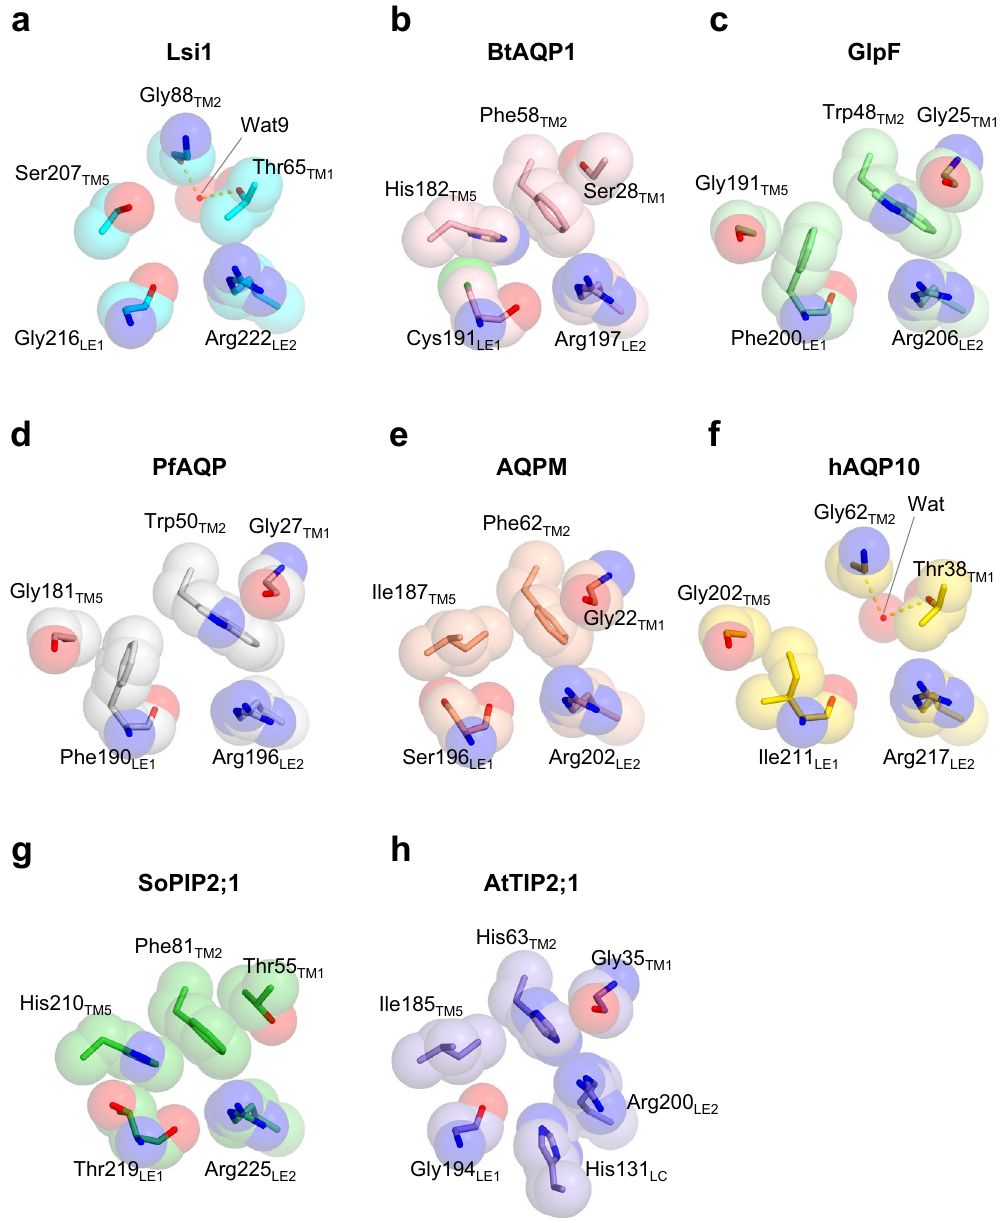
Fig. 3 Comparison of SFs of Lsi1 and other AQPs. SF of Lsi1 cryst ( a , cyan, PDB 7CJS), BtAQP1 ( b , pink, PDB 1J4N), GlpF ( c , light green, PDB 1FX8), PfAQP ( d , white, PDB 3C02), AQPM ( e , khaki, PDB 2F2B), hAQP10 ( f , yellow, PDB 6F7H), SoPIP2;1 ( g , green, PDB 1Z98), and AtTIP2;1 ( h , light purple PDB 5I32). The view directions are the same as Fig.